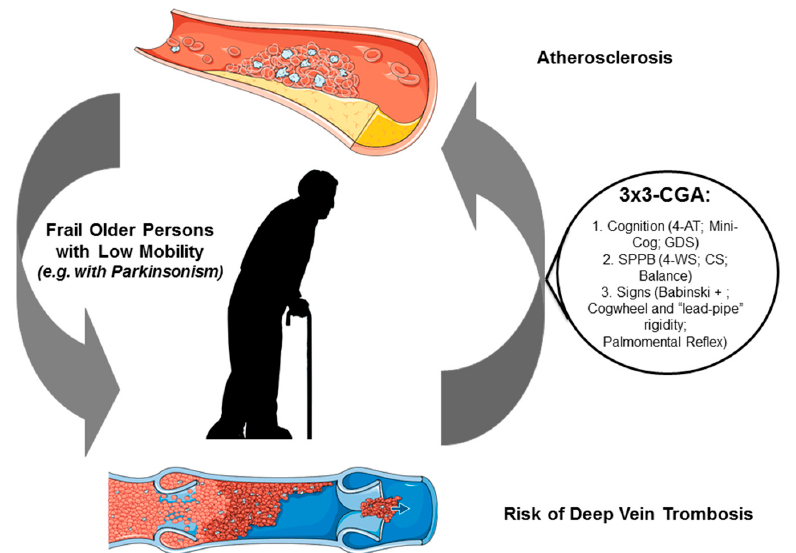
Figure 2. Main mechanisms that could increase the VTE risk in older individuals. The